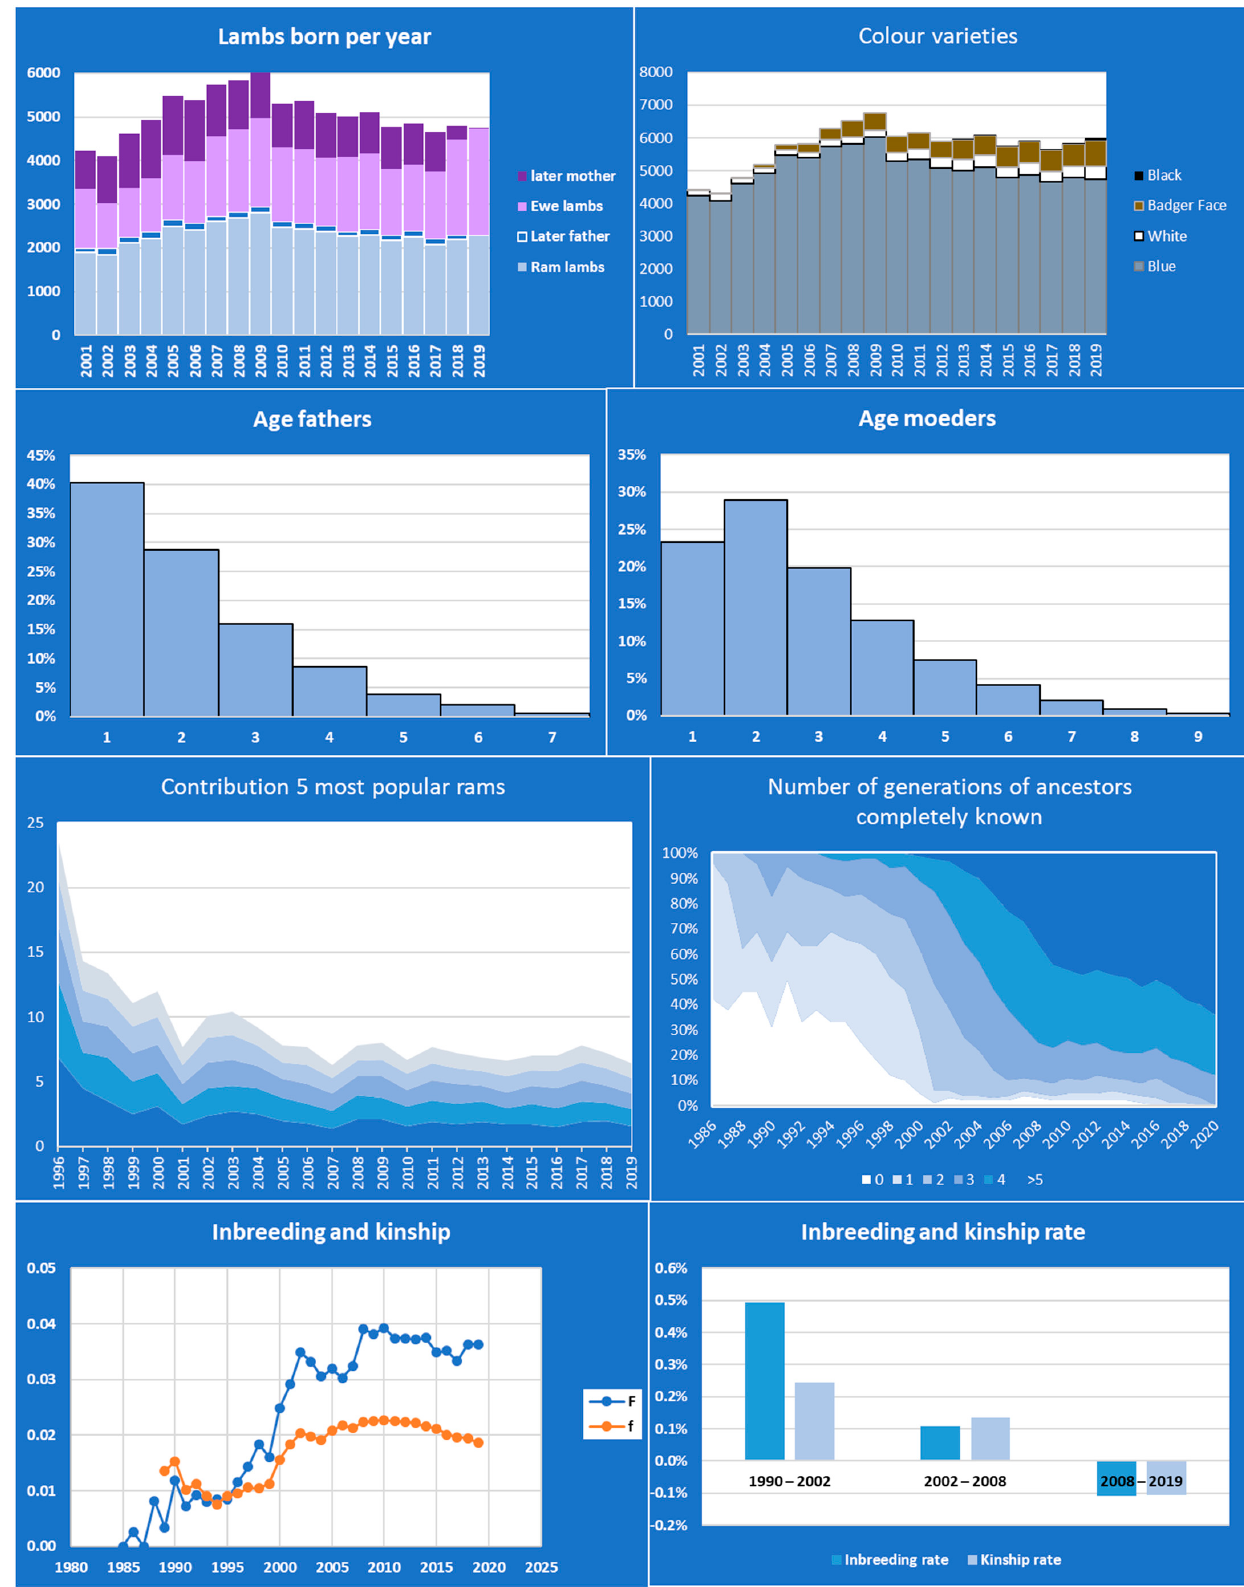
Figure 4. Main results from the Retriever software analysis of the Blue Texel herd book data.